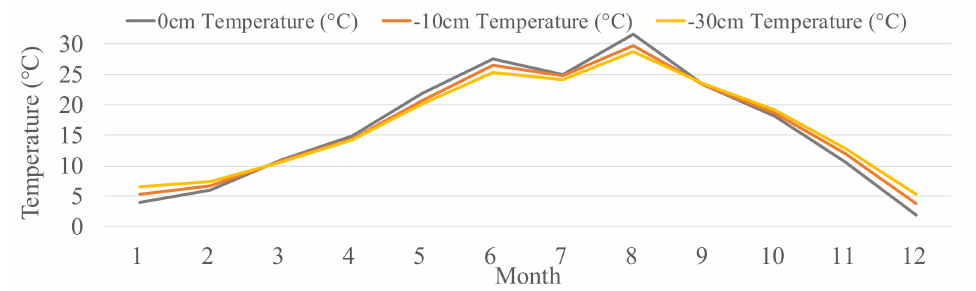
Figure 6. Underground temperature at 0, − 10, − 30 cm depth in Yangsan, South Korea.